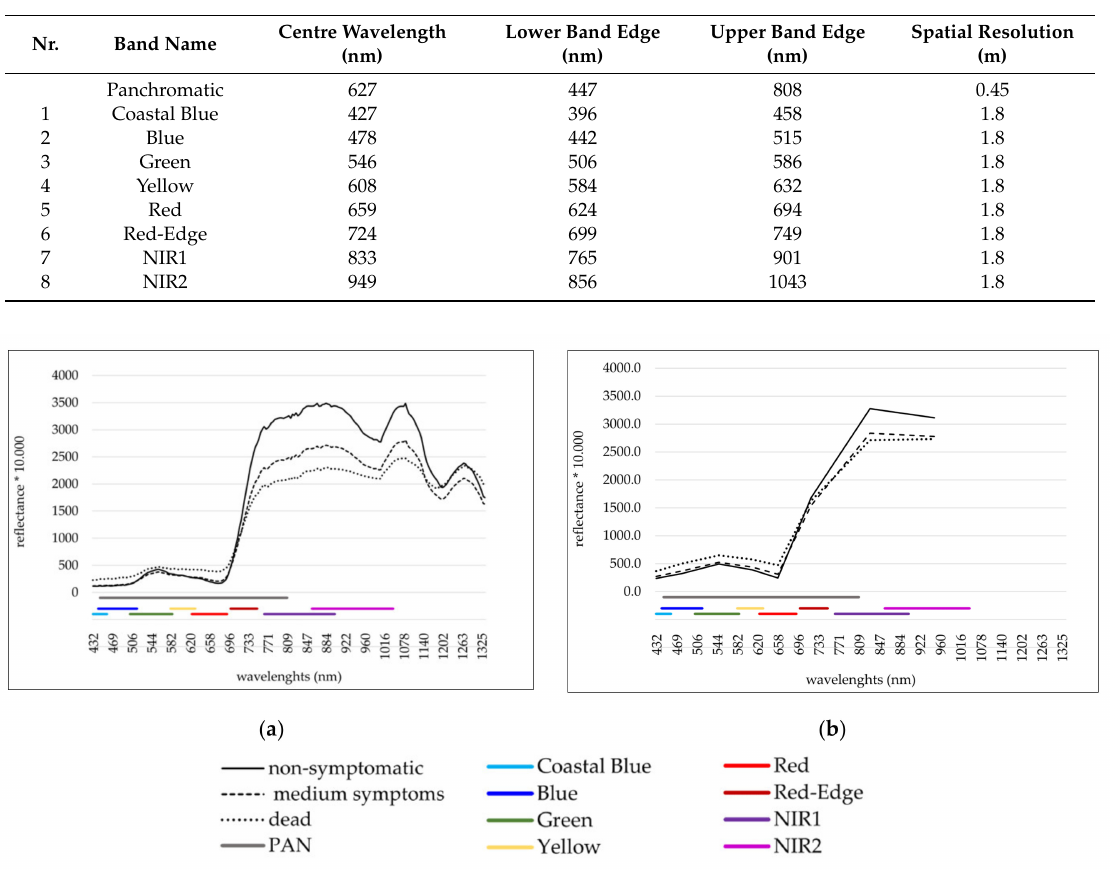
Table 1. WorldView-2 image: wavelengths, bandwidths, and spatial resolution [92]. NIR: near-infrared. Nr.